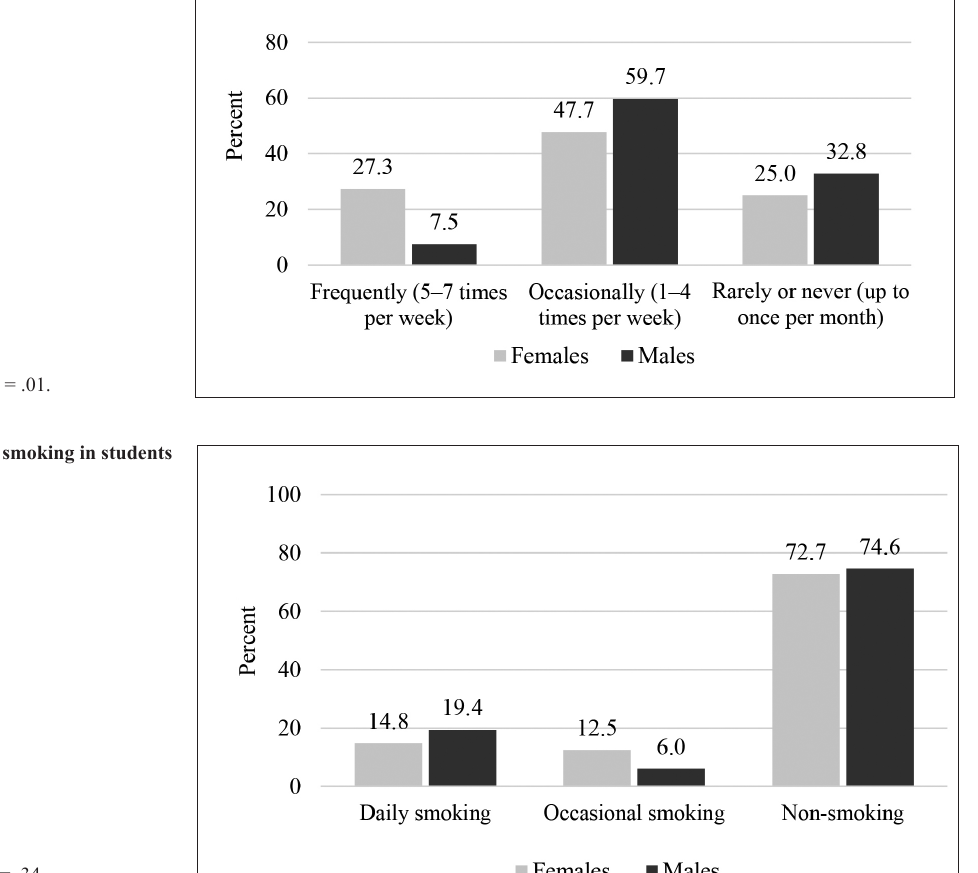
Figure 5. Sweet food consumption